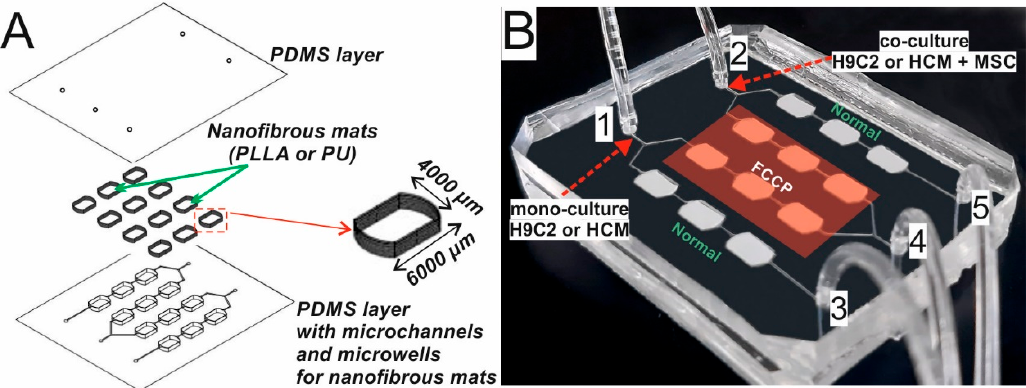
Figure 1. ( A ) A layout of the layers from which the microsystem is constructed. ( B ) The fabricated microsystem bonded with the second PDMS layer. Inlets are numbered: 1,2—inlets for cell suspension and outlets for reagents, 3,4,5—inlets for reagents and outlets for cell suspension (3,5—inlets for medium, 4—inlet for FCCP). PDMS–poly(dimethylsiloxane), PLLA-Poly-L-lactic acid, PU–polyurethane, FCCP-cyanide p-trifluoromethoxyphenylhydrazone, H9C2–rat cardiomyoblasts, HCM – human cardiac myocytes, MCS–mesenchymal stem cells.